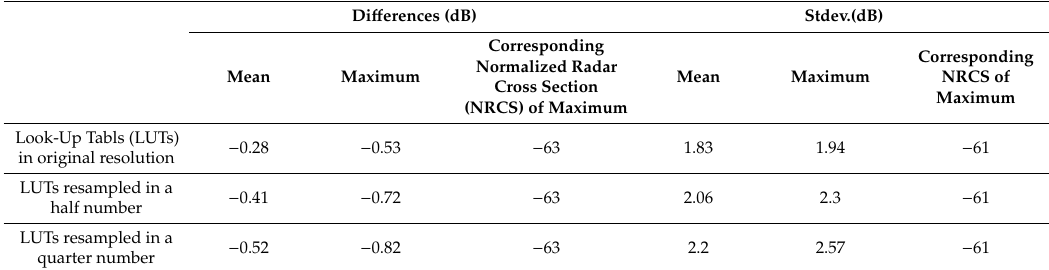
Table 2. Values from Figure